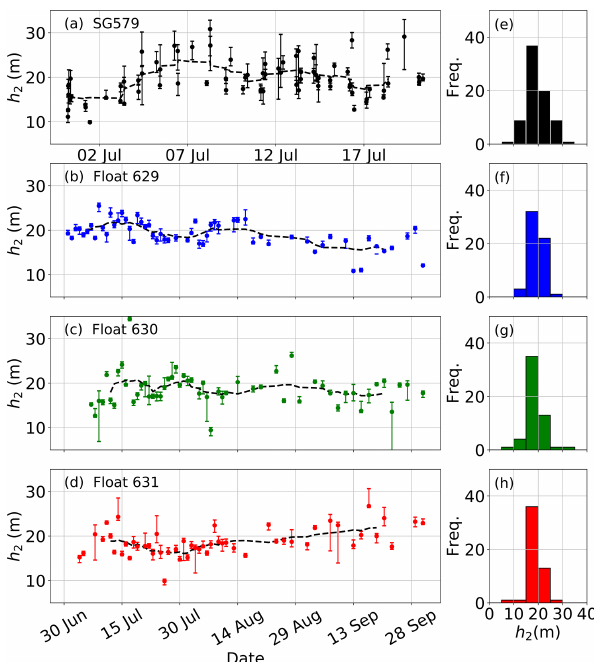
Figure 4. (a–d) Time series of observed h 2 : (a) glider SG579 (black), (b) float 629 (blue), (c) float 630 (green), and (d) float 631 (red). Dashed black lines represent a centred moving average of h 2 values with a window size of 10 data points. (e–h) Histograms of observed h 2 for each glider and floats with the same colour scheme as the time series. The error bars indicate the uncertainty of derived values of h 2 .